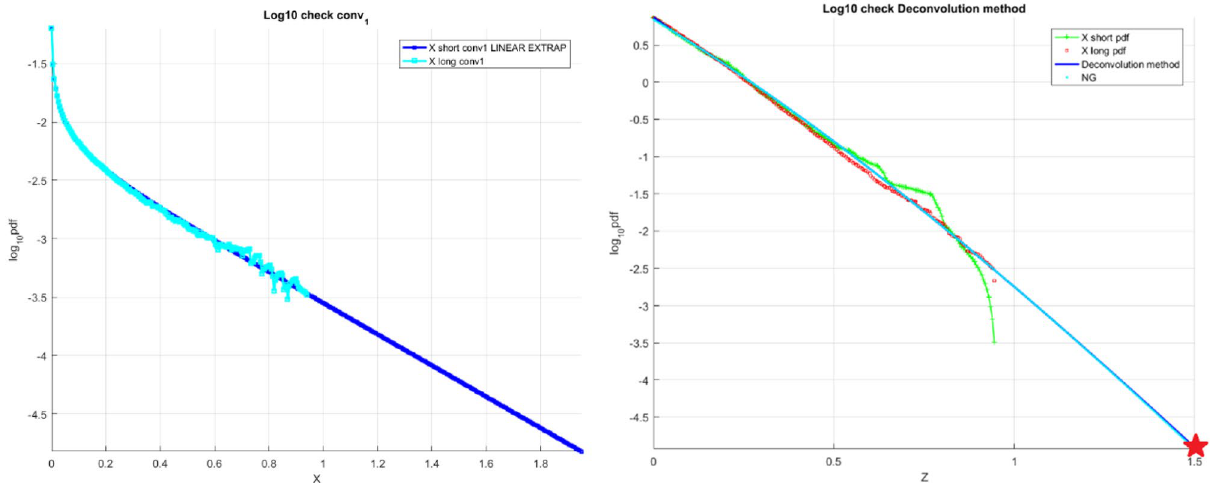
Figure 6. Wind speed data. Left: scaled f X 1 tail on the decimal log scale for the «shorter» data (cyan), linearly extrapolated (dark blue). Right: unscaled raw «shorter» data (green) f X tail on the decimal log scale, extrapolated by the deconvolution method (dark blue), along with «longer» raw data (red) and NG extrapolation (cyan). Star indicates 100 years return period